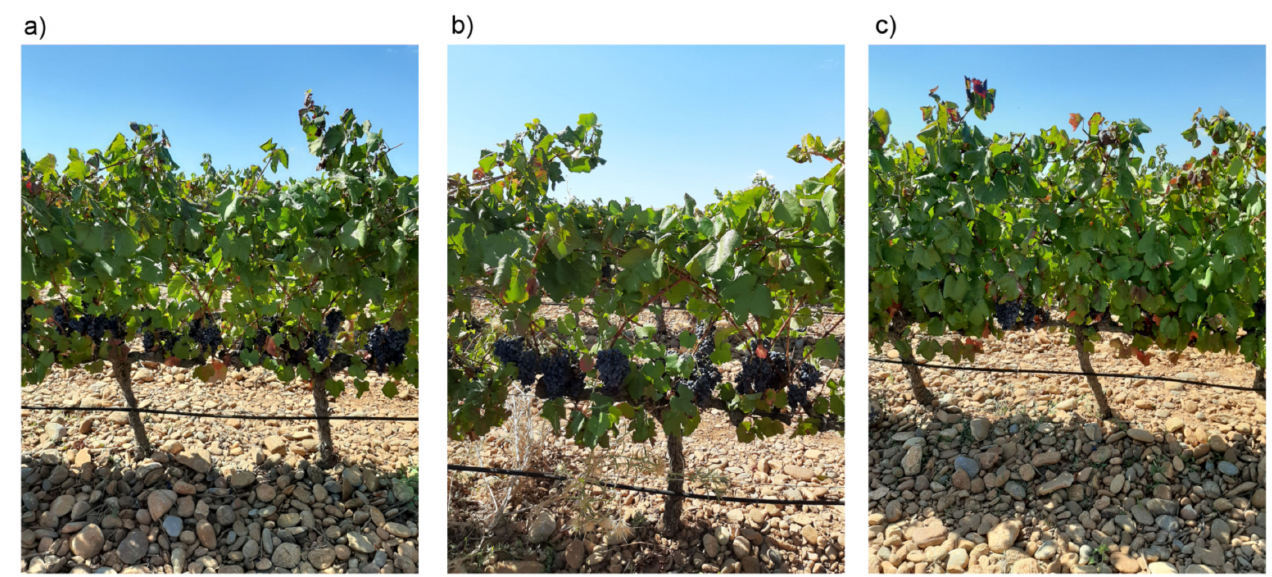
Figure 2. Field photos representing the different leaf removal treatments: ( a ) one side; ( b ) two sides; ( c )